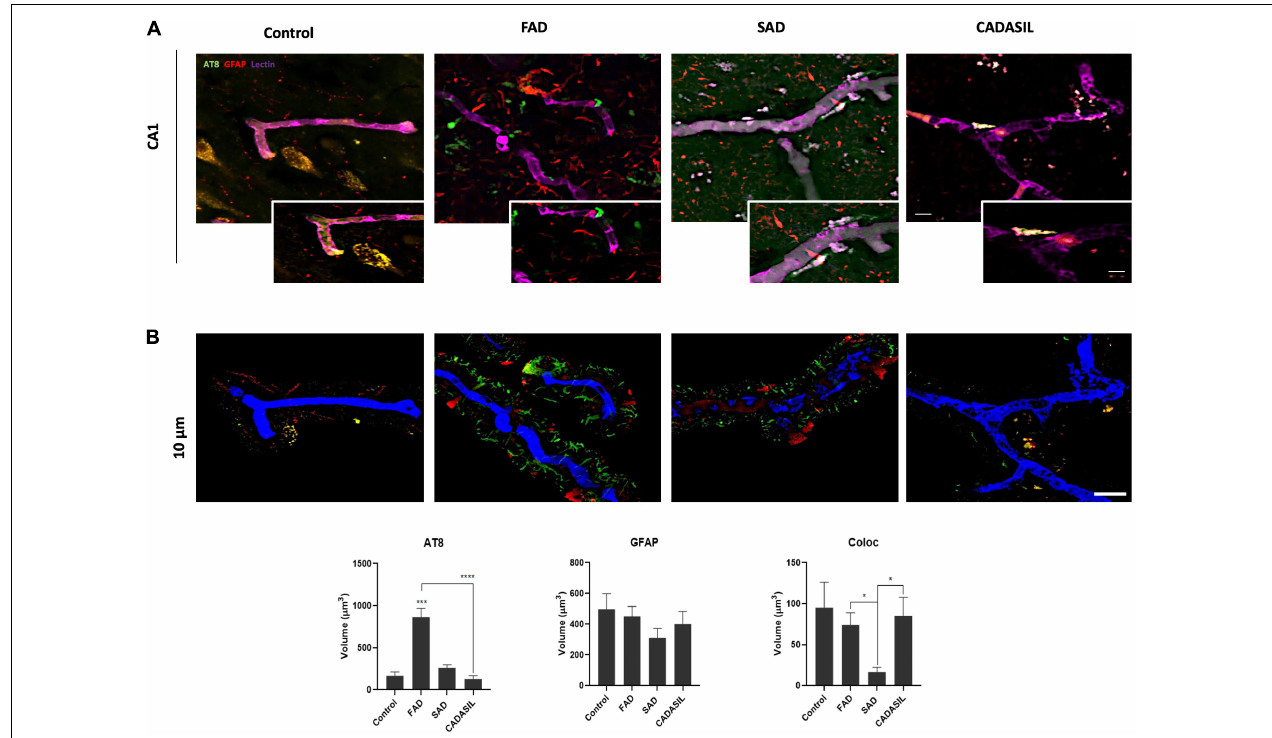
FIGURE 3 | PHF-tau association with astrocytes and vessels in dementia brains. (A) Z projection of Immunofluorescence of blood vessels triple-stained with DyLight 649 UEA (blue), PHF-tau antibody probed with Alexa Fluor 488 (green), and reactive astrocytes marked with Alexa Fluor 594 (red) in the hippocampal CA1 area. Magnification: 60x. Scale bar: 25 µ m. Insets: 5 µ m scale bar in A. (B) Z projection of the deconvolved images from the 3D reconstruction of the confocal images in A showing the triple staining present at 0 to 10 µ m away from the vessel surface. Scale bar: 25 µ m. The quantification of the volume in µ m 3 for the levels of PHF-tau and GFAP and the colocalization between PHF-tau and GFAP. The data are expressed as the means ± SEM. n = 4. * p < 0.05; *** p < 0.001; **** p <